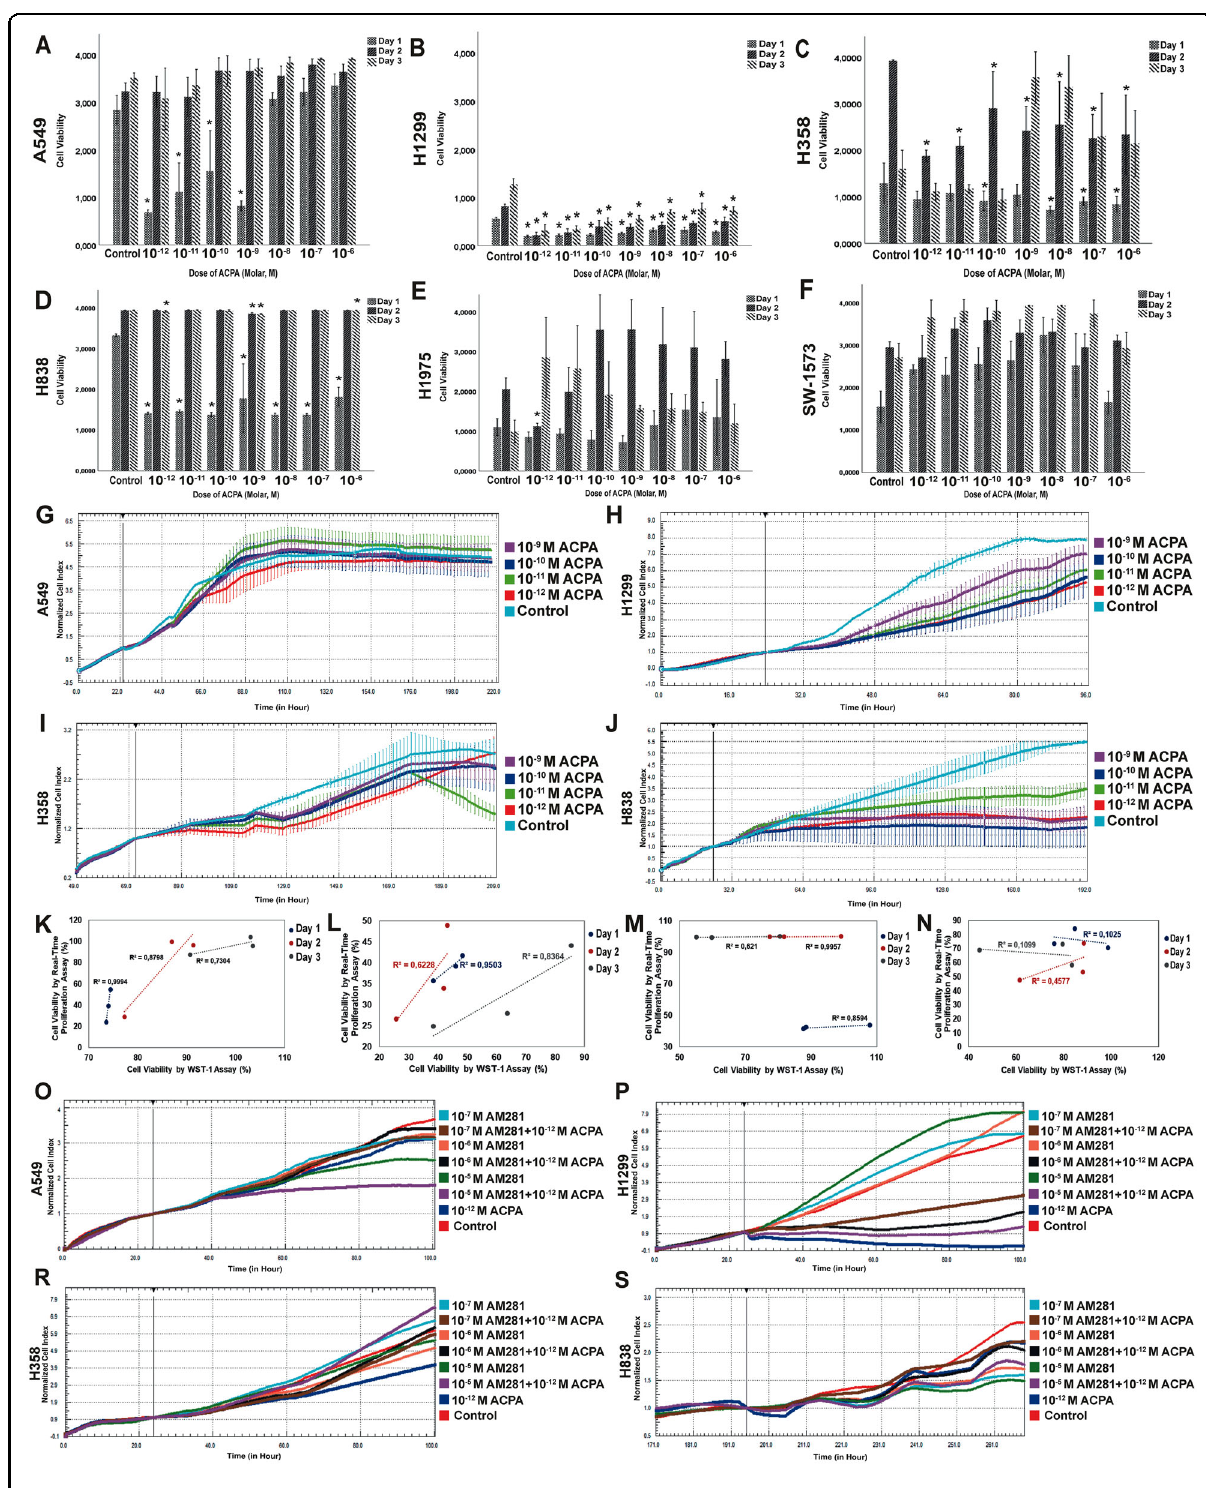
Fig. 2 (See legend on next